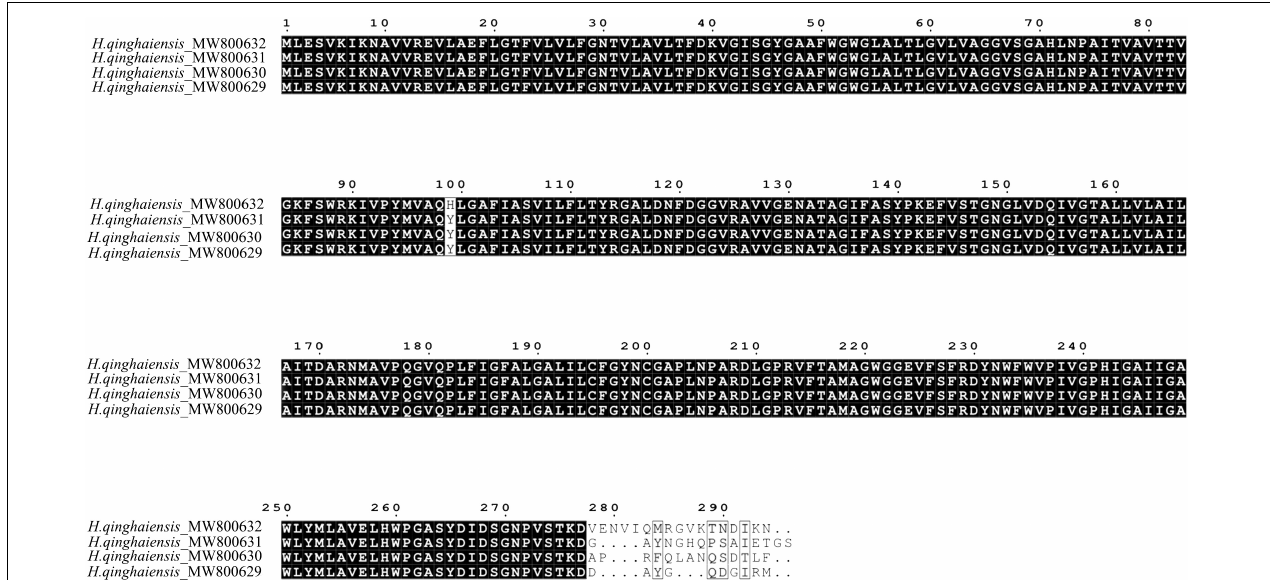
FIGURE 1 | Alignment of predicted amino acid sequences of four H. qinghaiensis aquaporin (AQP) transcript variants.